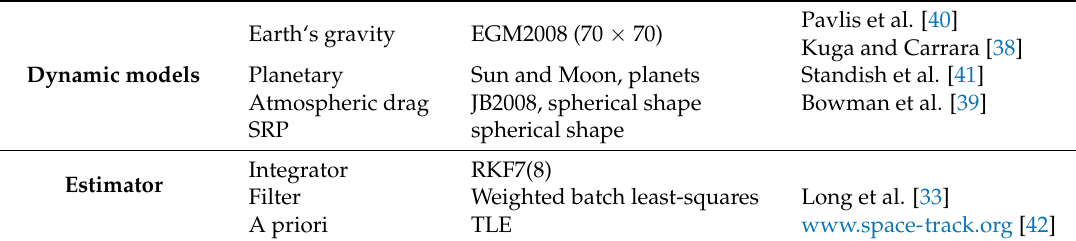
Table 3. The batch least-squares orbit estimator setup and dynamic models to calculate perturbations. The Jacchia-Bowman 2008 model was used as the atmospheric drag model to reduce the error of models by irregular solar